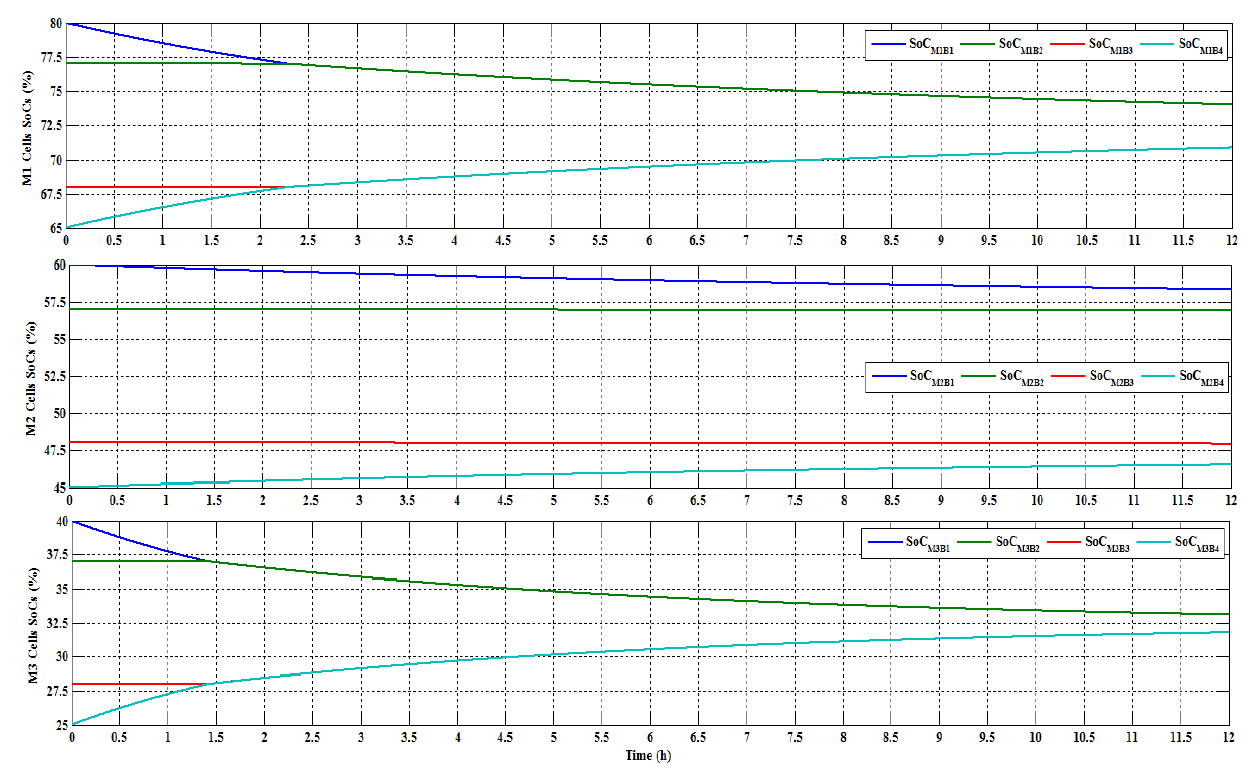
Figure 9. Simulation No. 1 (SSCs only) results: Module 1 cells SoCs, Module 2 cells SoCs, and Module 3 cells